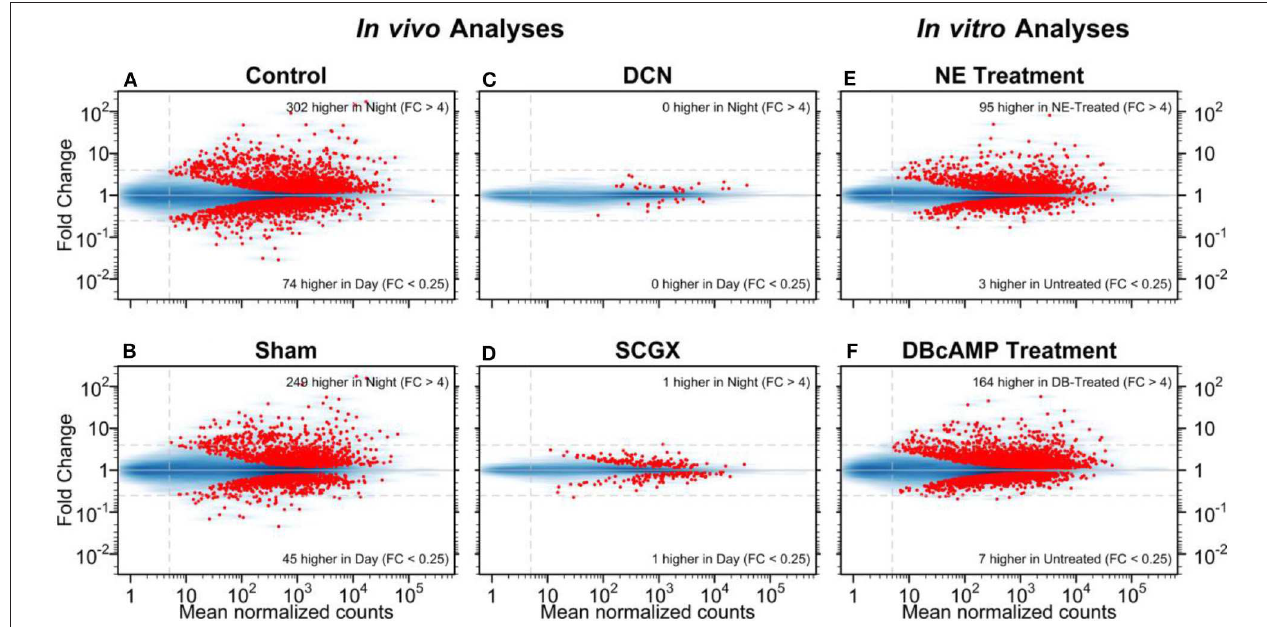
FIGURE 1 | Day/night differences in gene expression. The mean normalized read-pair counts (x-axis) vs. the estimated fold change (y-axis) are displayed on a log-log scale. Four in vivo and two in vitro analyses are presented as MA plots. The blue shading indicates the density of genes, and each red point represents a gene with statistically significant differential expression (adjusted- p < 0.001). Dashed horizontal lines mark 4-fold changes in both directions; the dashed vertical line indicates the minimum abundance threshold for the statistical tests. The four in vivo analyses compared night and day time points in adult rats for the following groups: (A) no surgery (Control); (B) neonatal sham surgery (Sham); (C) neonatal superior cervical ganglia decentralization (DCN); (D) neonatal superior cervical ganglionectomy (SCGX). The two in vitro analyses compared treated/untreated pineal glands: (E) norepinephrine-treated (NE) vs. untreated and (F) dibutyryl-cyclic-AMP-treated (DBcAMP) vs untreated. Reproduced from Hartley et al. (25). This figure and associated legend is published with permission of the original publisher under license